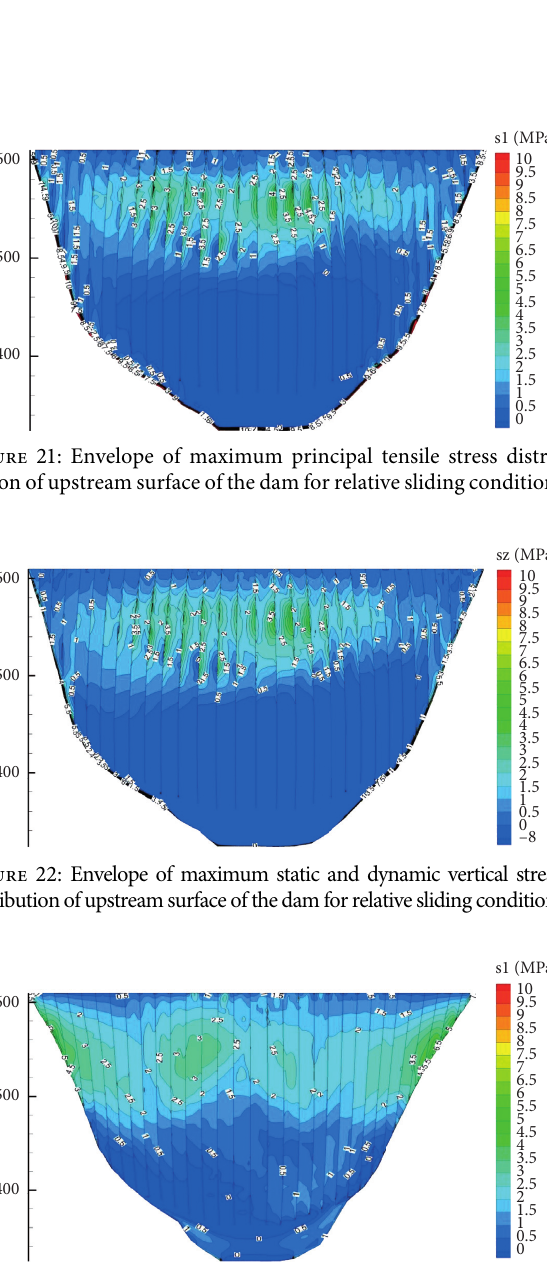
Figure 23: Envelope of maximum principal tensile stress distri- bution of downstream surface of the dam for no-slip condition [13].